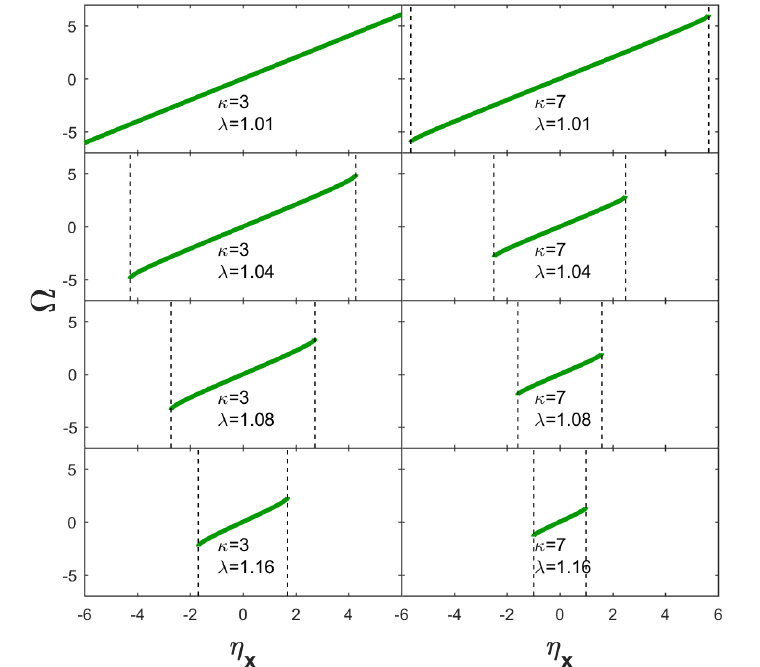
Figure 4. Fluid rapidity distributions versus space-time rapidity η x from the new, longitudinally finite solutions for κ = 3 (left column) and for κ = 7 (right column) evaluated for the acceleration parameters λ = 1.01, 1.04, 1.08 and 1.16 (from top to bottom rows) corresponding to gradually narrowing rapidity distributions with increasing acceleration parameter. Note that, in our solutions, the Ω ( η x ) functions are approximately, but not exactly, linear functions of the space-time rapidity η x , but they are exactly independent of the proper-time τ